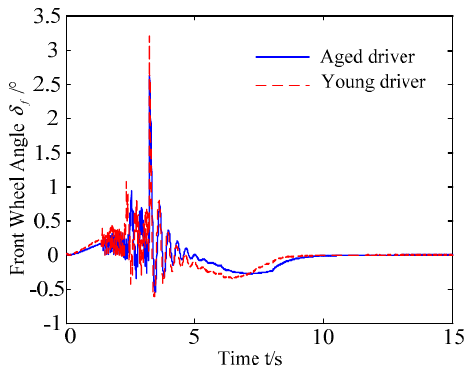
Figure 22. Front wheel angle of vehicle p under different handling characteristics.